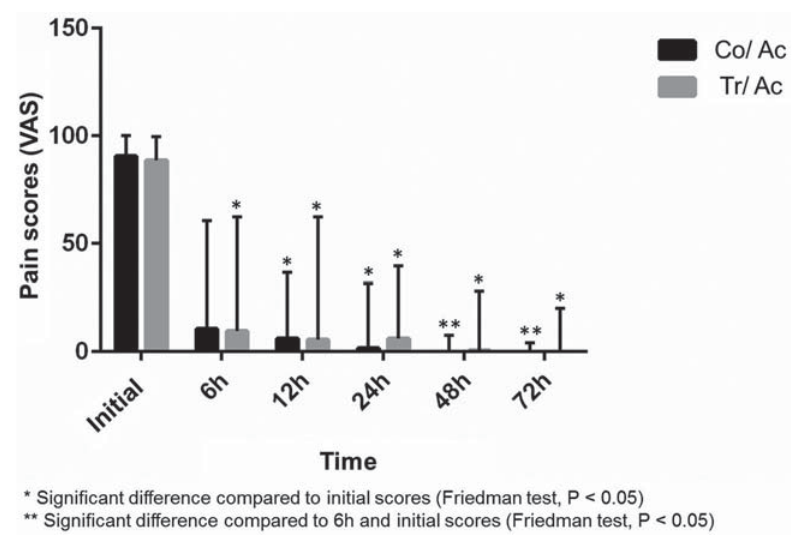
Comparison of two combinations of opioid and non-opioid analgesics for acute periradicular abscess: a randomized clinical